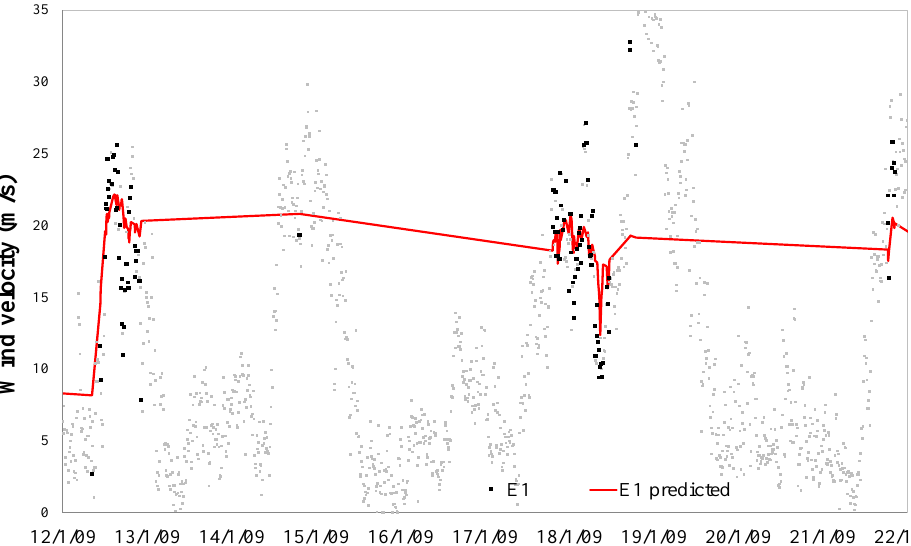
Figure 4. Validation of the predicted limit speed of error 1 versus real errors.